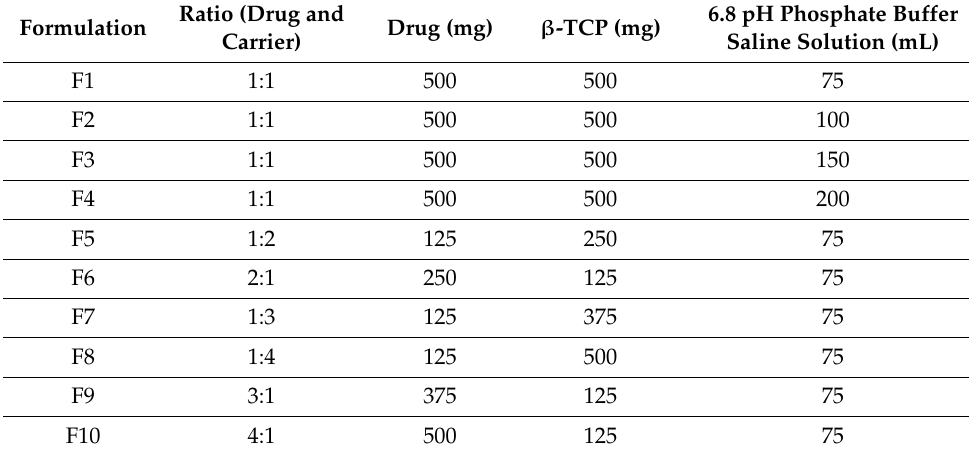
Table 3. Composition of nanocarriers’